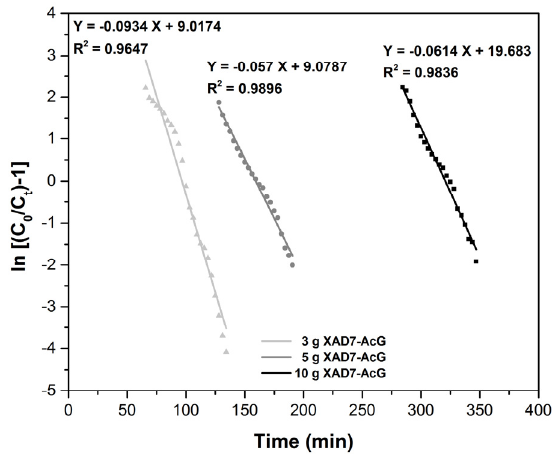
Figure 7. Thomas plots for the adsorption of Au (III) in the fixed-bed column, at various amounts of adsorbent material.